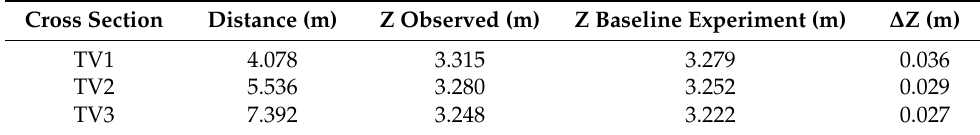
Table 2. The simulation results in baseline experiment and observer data. Cross Section Cross Section Distance (m) Z Observed (m) Z Baseline Experiment (m)